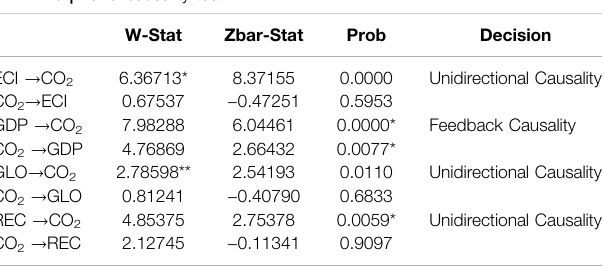
TABLE 9 | Panel causality